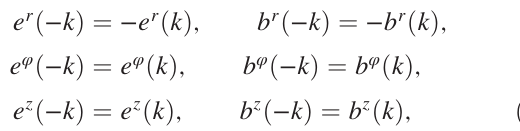
β Þ J 0 β Þ − Y 0 β Þ J β Þ . All other quantities are defined in m ð m ð m ð m ð